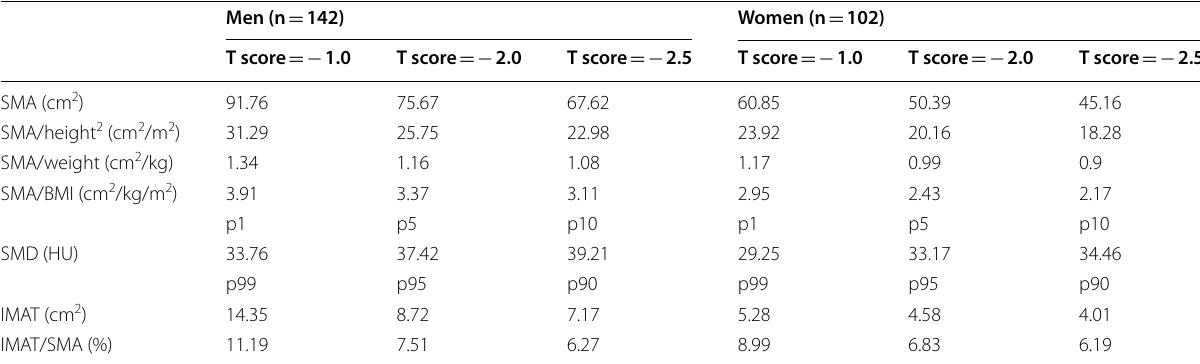
Table 2 Reference data from the young reference group (20–40 years) regarding SMA, SMD, IMAT, and their indices